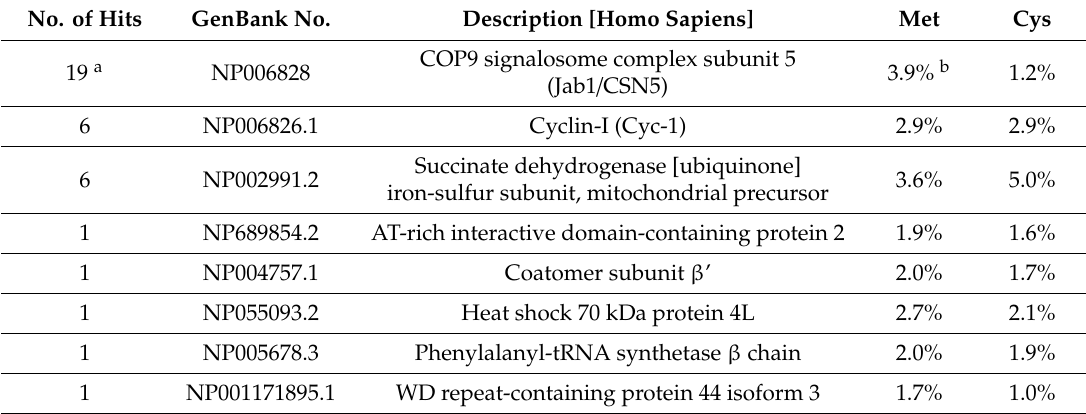
Table 1. Msr type A enzyme (MsrA) interacting proteins identified by yeast two-hybrid system